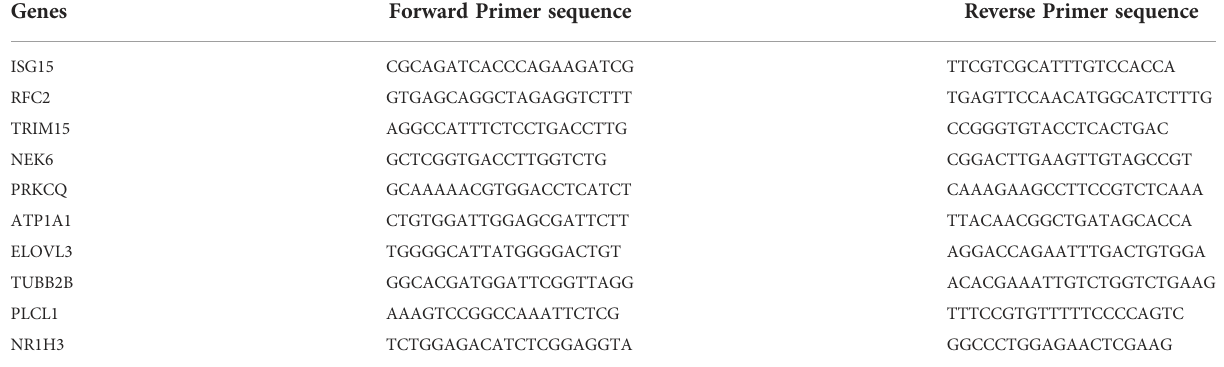
TABLE 1 The primers used in qRT-PCR of the TRG risk model genes. Genes Forward Primer